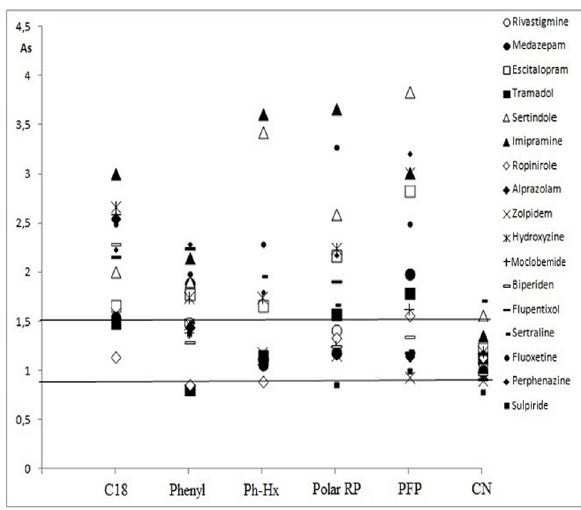
Figure 4: Graphical comparison of As values obtained on different columns with mobile phases containing as eluent 30% acetonitrile, 20%acetate buffer at pH 3.5 and 0.025 ML -1